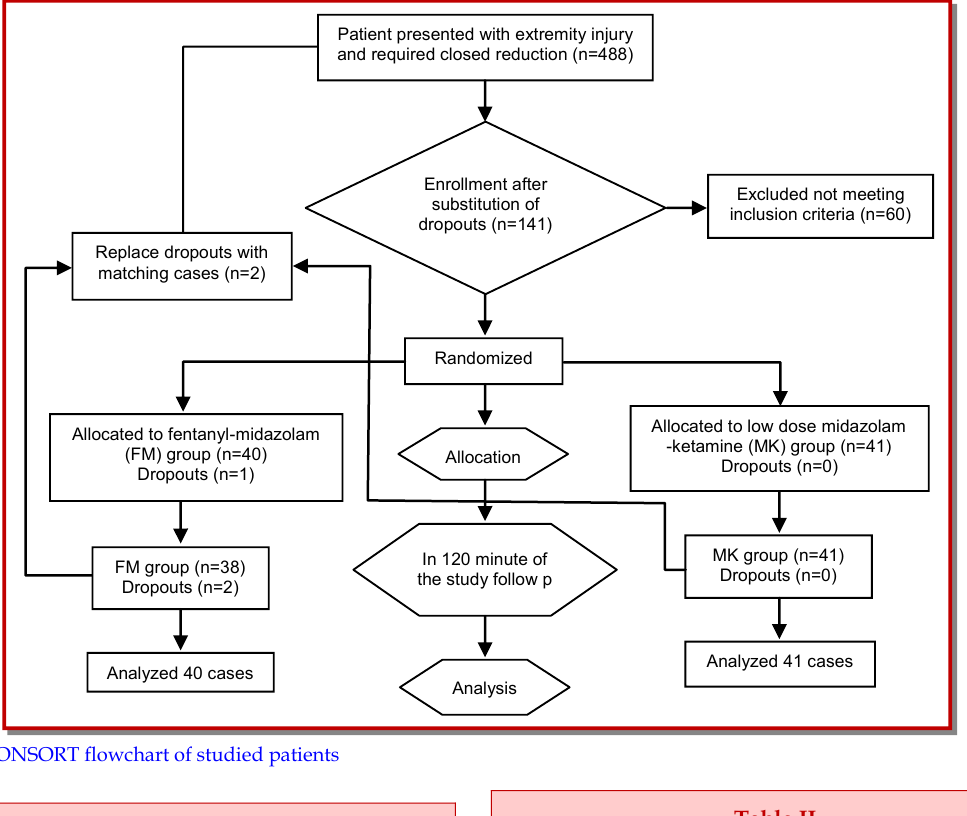
Demographic and baseline characteristics Outcomes of studied patients